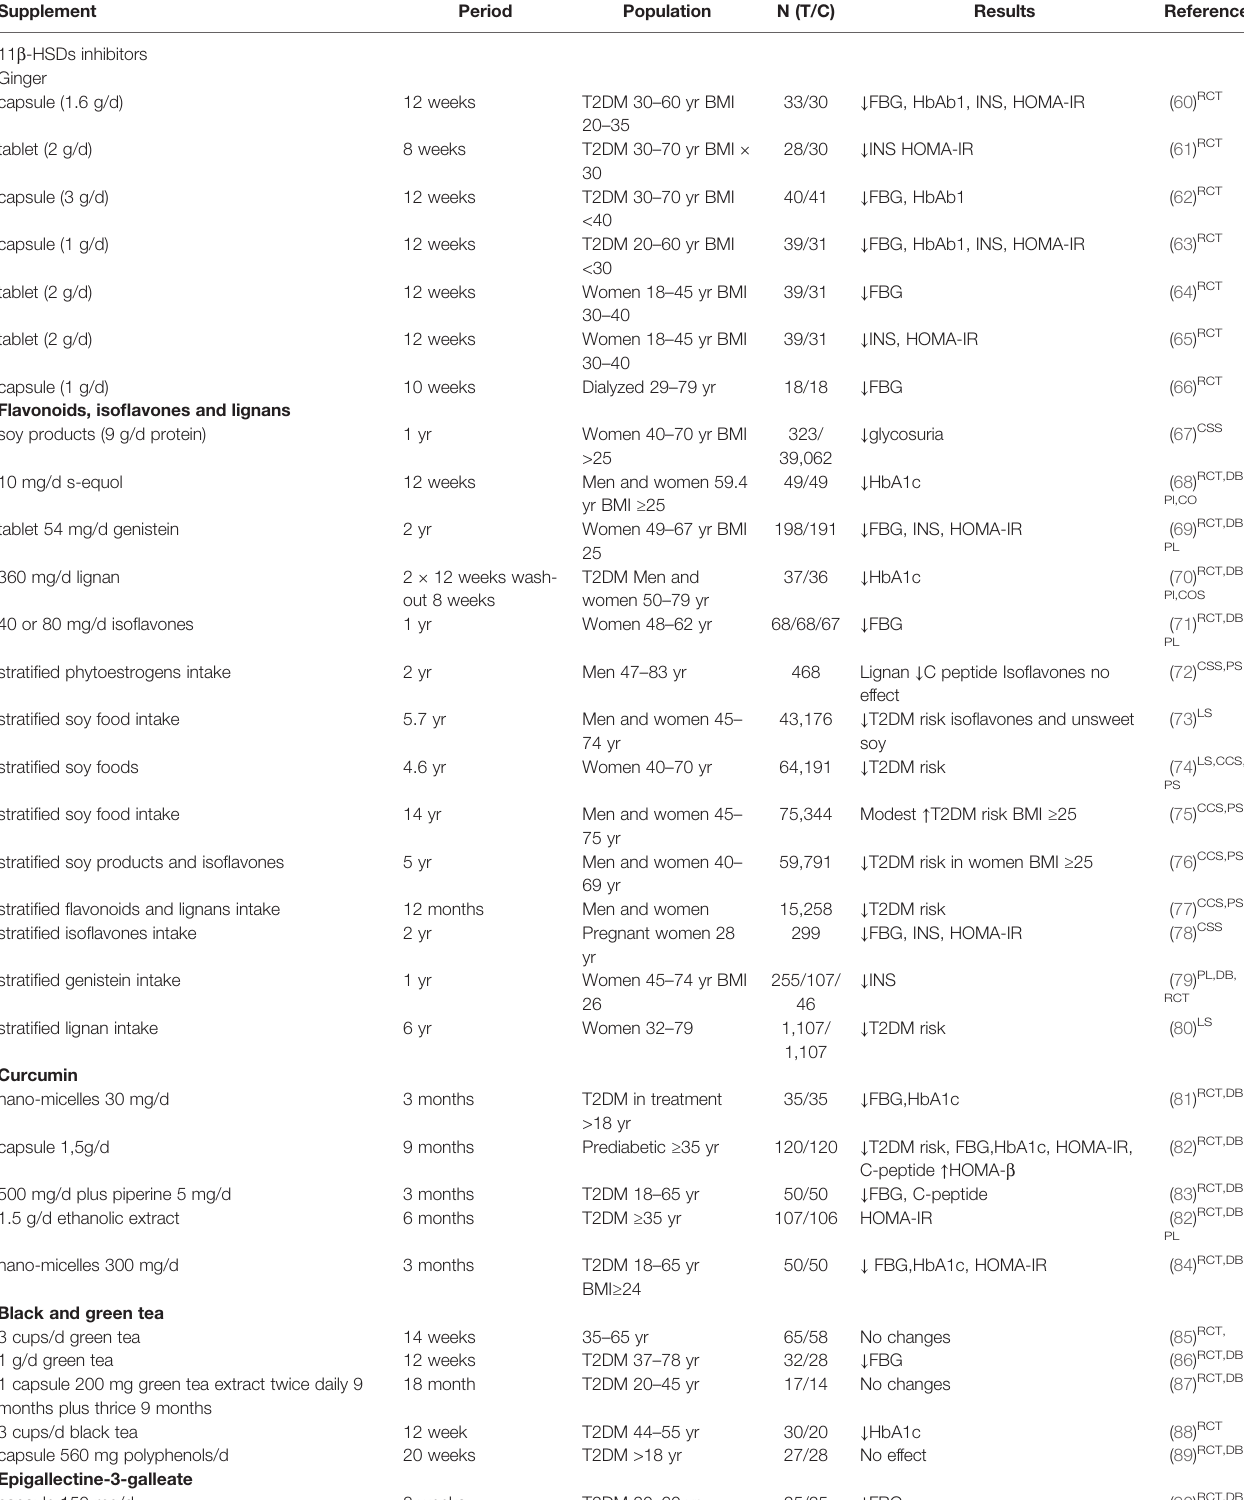
TABLE 1 | Clinical trials related to natural epidrugs to treat Type 2 Diabetes